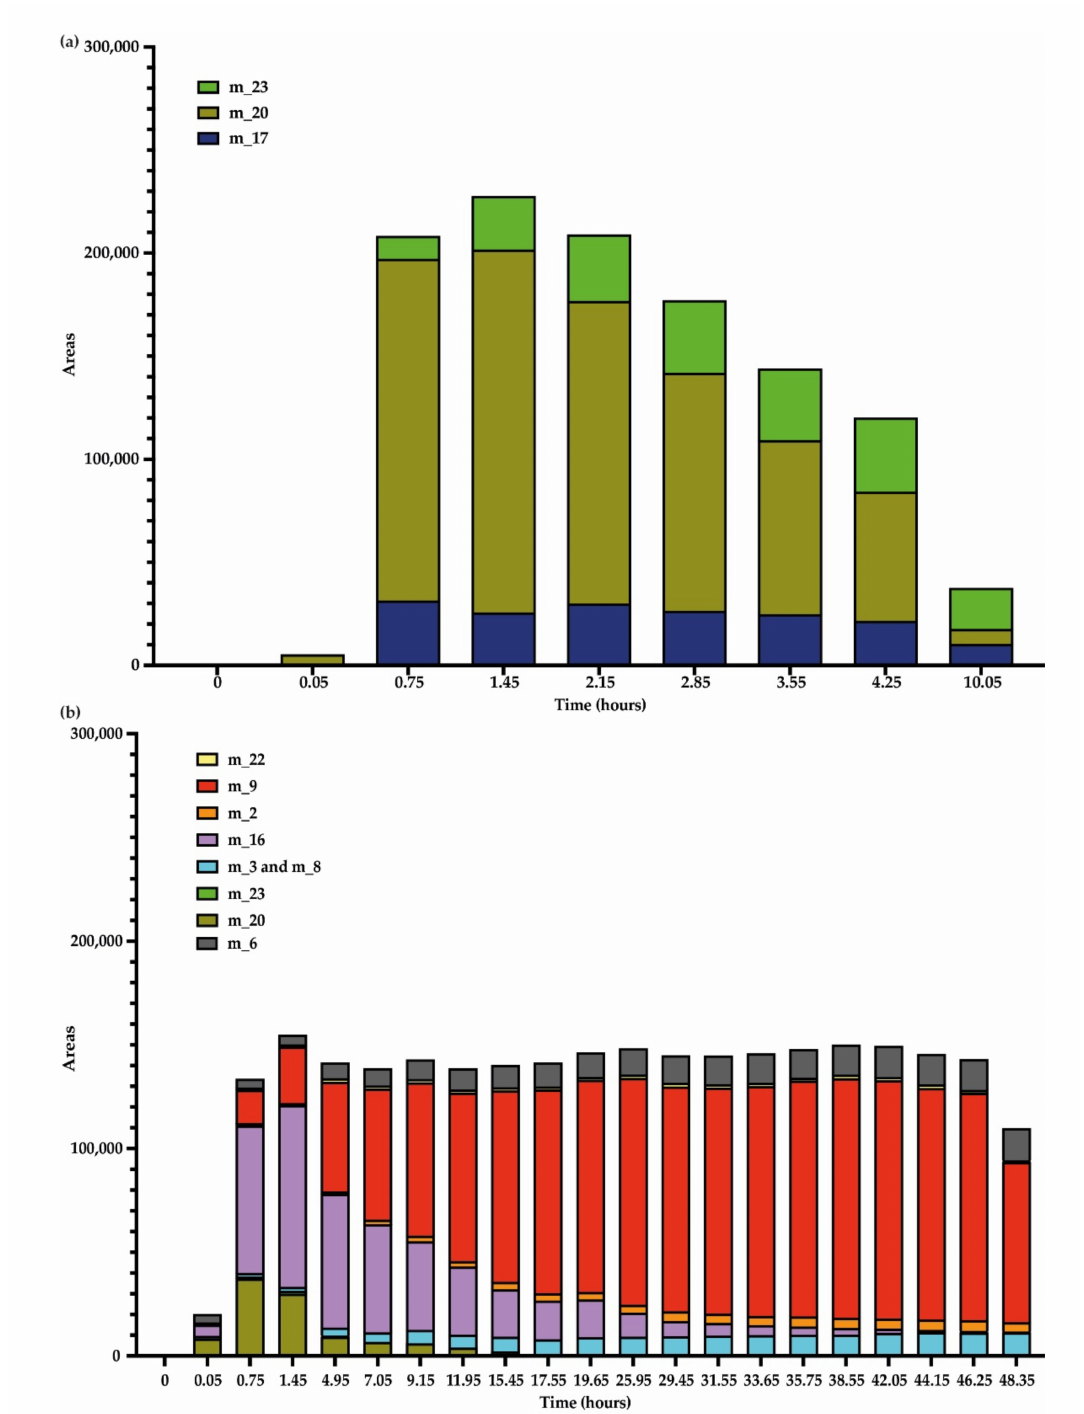
Figure 12. Unknown/Putative metabolization products observed during kinetic monitoring of trans -piceatannol (5 µ g/mL) metabolization in sodium acetate buffer by total extracellular protein extract from ( a ) D. seriata (200 µ g/mL) and ( b ) N. parvum (1 mg/mL). Mean was calculated over three biological replicates each comprising two technical replicates ( n =